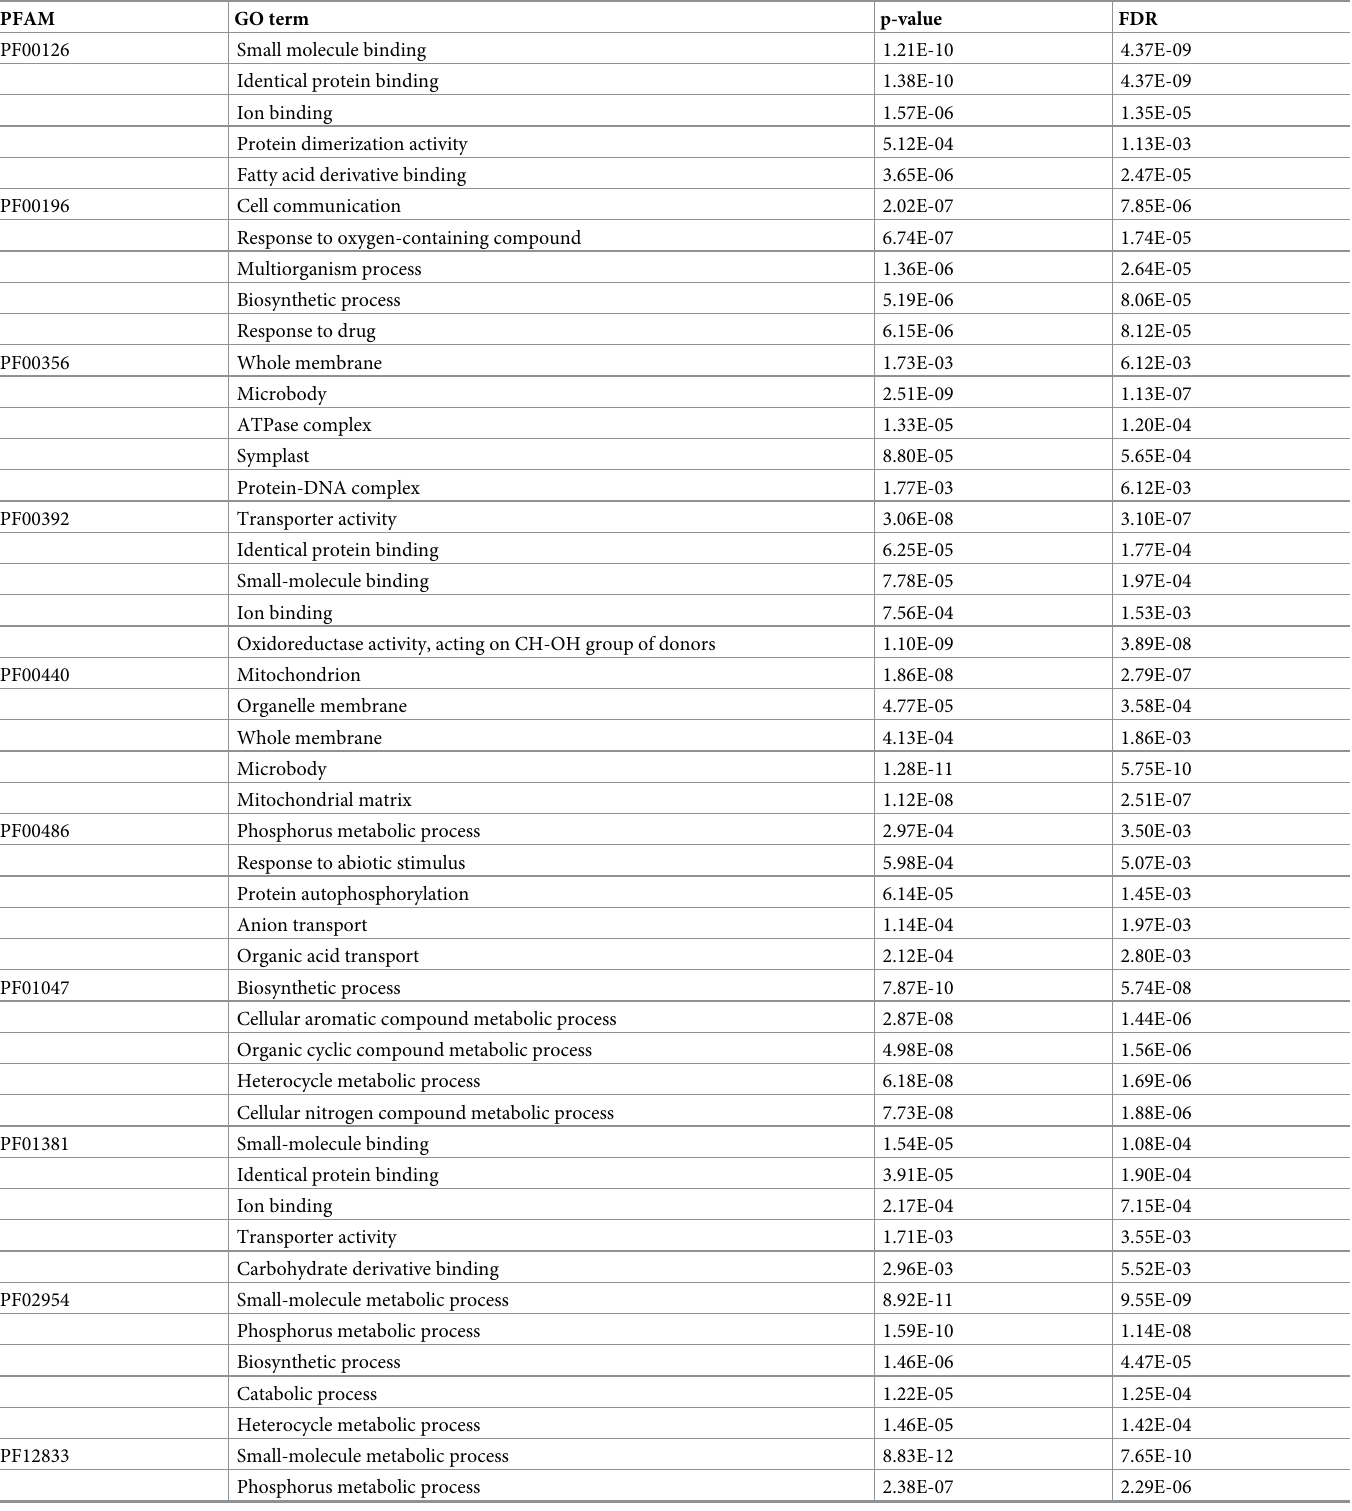
Table 3. Main functions identified by PFAM annotations of neighbor